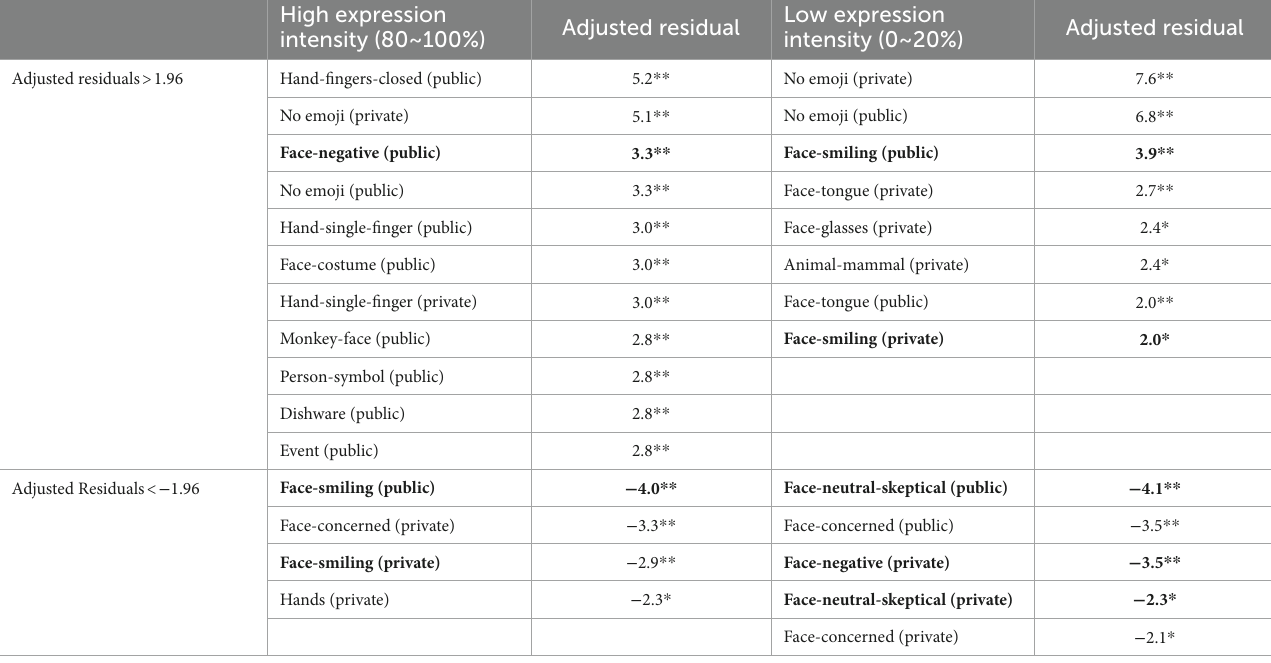
subjective happiness. No significant associations were found between age, depressive symptoms, and